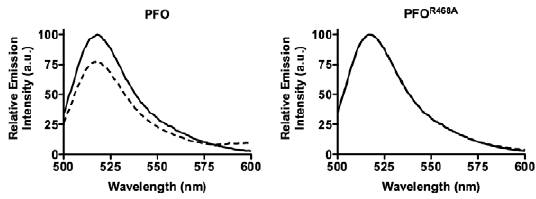
Figure 4. FRET-detected monomer association of PFO and PFO R468A . A cysteine was substituted for Asp-30, located in domain 1 and the derivatives were labeled with Alexa Fluor 488 (donor, D) or Alexa Fluor 568 (acceptor, A).A 4:1 molar ratio of A-labeled PFO R468A (dashed line) or unlabeled PFO R468A (U; solid line) to D-labeled toxin was incubated in the presence of human erythrocyte ghost membranes and